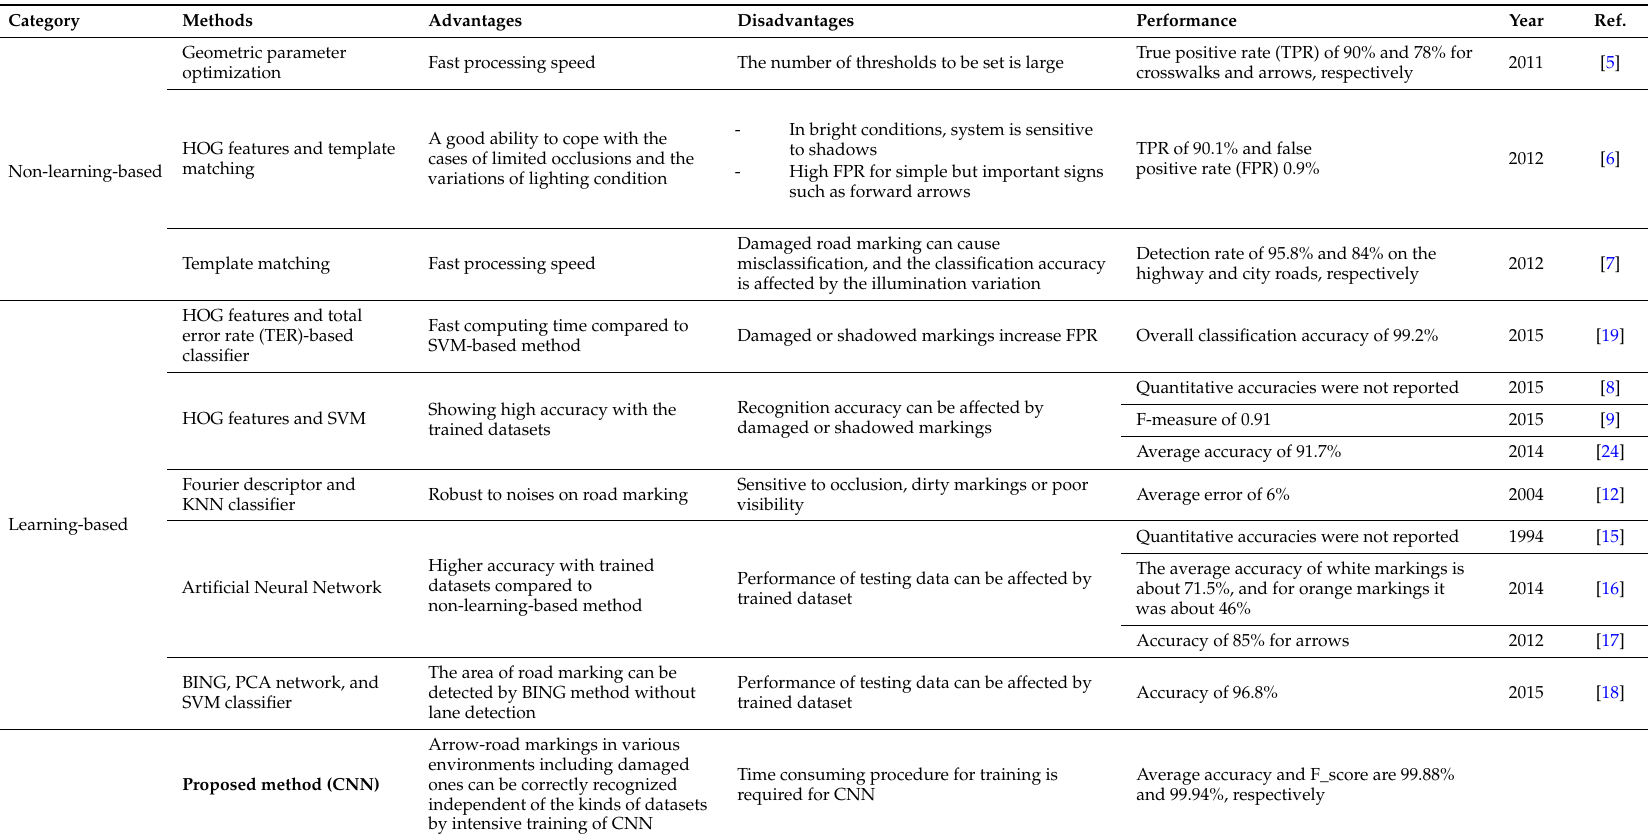
Table 1. Comparisons of previous and proposed